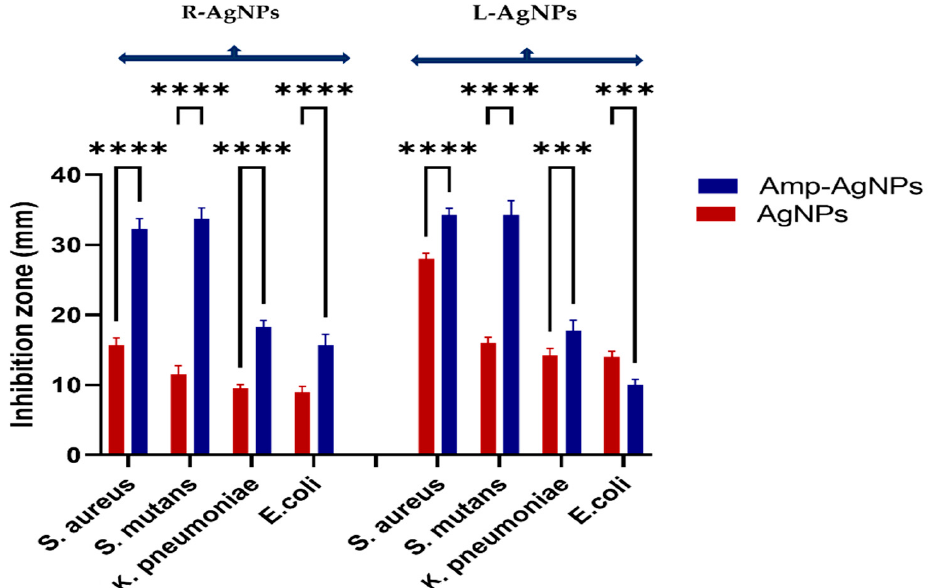
Figure 17. Antibacterial activity of AgNPs and Amp-AgNPs. Agar disc zonal inhibition method measuring antibacterial activity as inhibition zones (mm) of AgNPs and Amp-AgNPs against four different bacteria. Two-way ANOVA with multiple comparison was performed to identify differences between groups. p < 0.0001 (****), p < 0.001 (***).